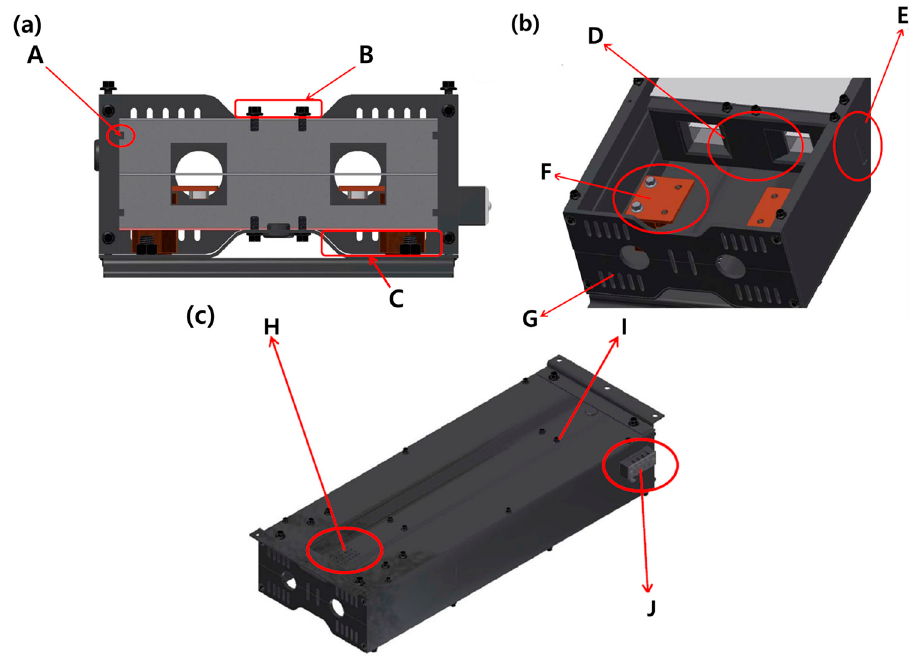
Figure 2. Pickup module prototype fabrication concept: ( a ) Front section view, ( b ) inside view of the rear part, and ( c ) three-dimensional view. The uppercase English alphabet represents design improvements to ensure mass production and reliability, and detailed descriptions of design improvements are described in the main text.